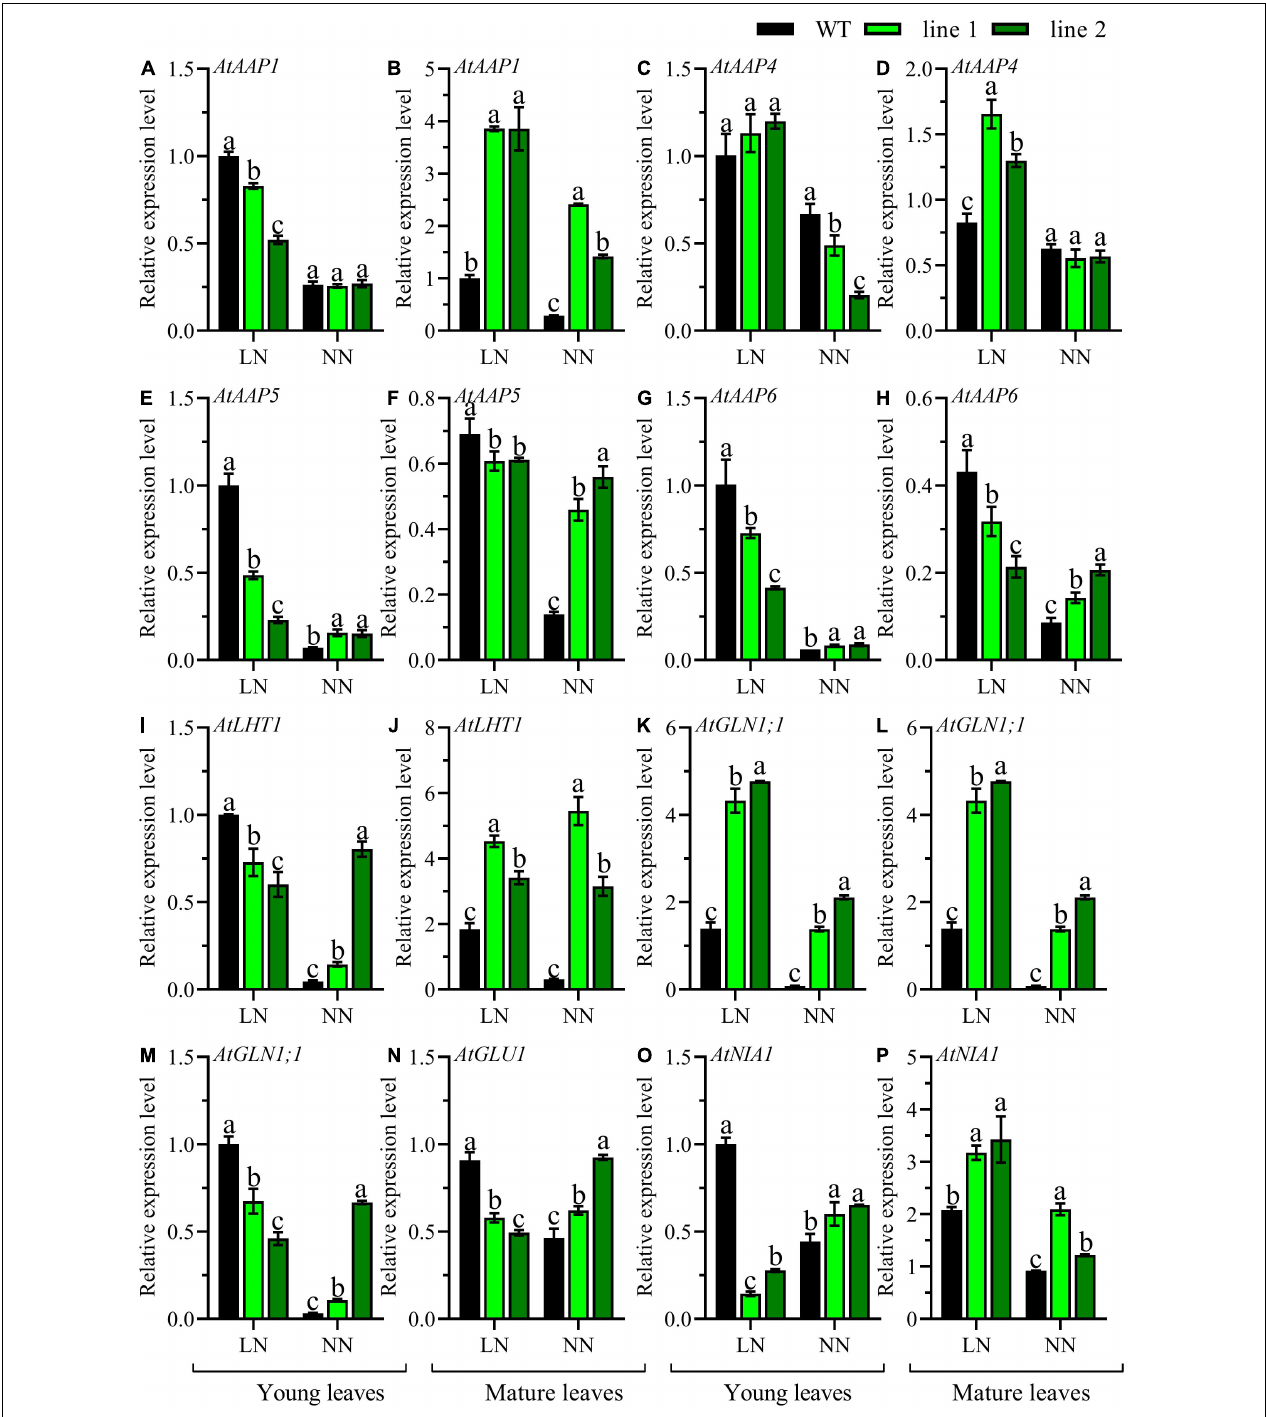
FIGURE 5 | Comparable expression analysis of genes associated with N assimilation in the mature leaves and young leaves between two transgenic Arabidopsis lines and wild type. Plants were hydroponically cultured for 3 weeks under NN, and then under LN and NN for 2 weeks ( n ≥ 3). AAP , Amino acid permease; LHT , Lysine histidine transporter; GLN , Gln synthetase; GLU , Gln 2-oxoglutarate aminotransferase; NIA , nitrate reductase. (A,C,E,G,I,K,M,O) Genes expressed in young leaves. (B,D,F,H,J,L,N,P) Genes expressed in mature leaves. AtGAPDH was used as the internal control, and the expression level in young leaves of WT under LN was set as “1” for each gene. Three technical replicates were performed. Data are means ± SD. Significant differences are indicated by letters (ANOVA; P ≤ 0.05). WT, wild type (Col-0), line 1 and line 2, two transgenic lines. LN, low nitrogen, 0.25 mM N (0.125 mM NH 4 NO 3 ); NN, normal nitrogen, 5 mM N (2.5 mM NH 4 NO 3 ).